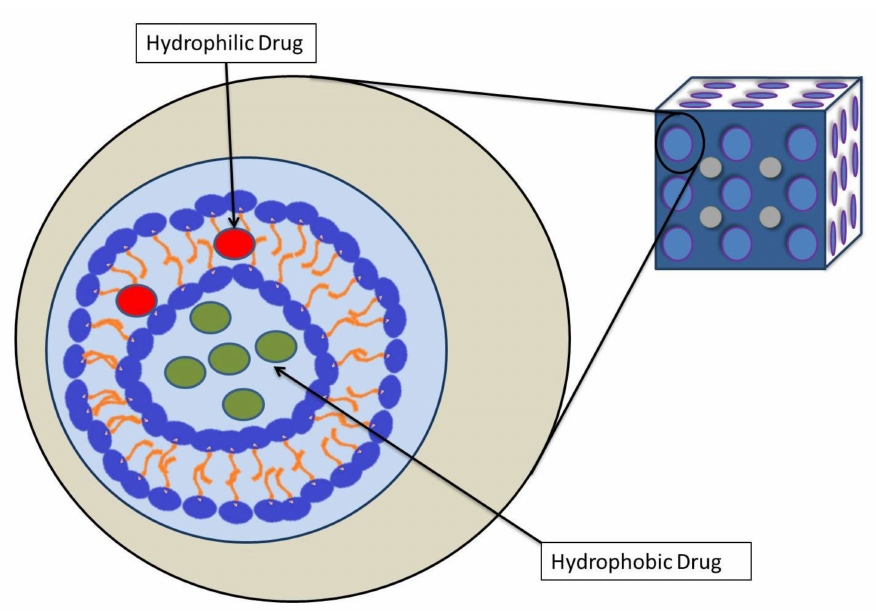
Figure 2. Structure of